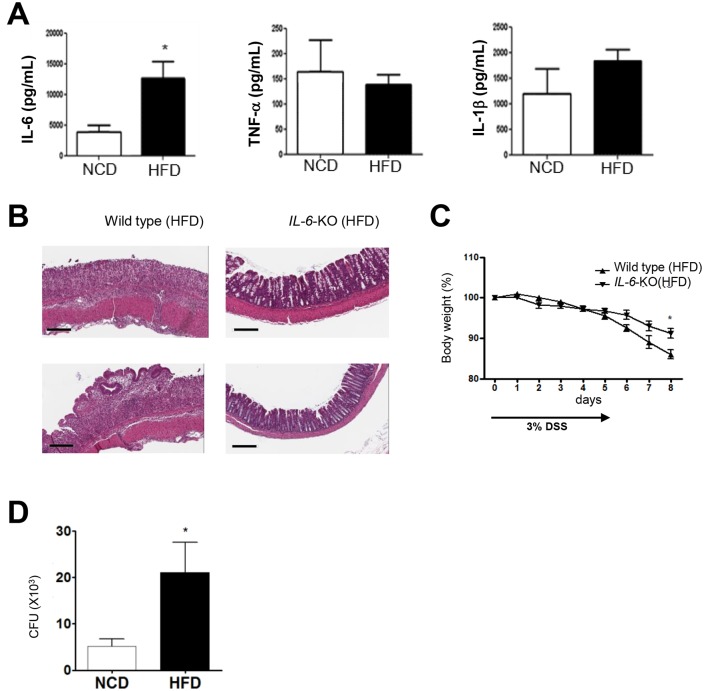
Cytokines in experimental colitis of high-fat diet (HFD)-fed mice.(A) Cytokine content in culture supernatant following overnight incubation of tissue explants was determined by ELISA on day 7 of dextran sodium sulfate (DSS) treatment. (B and C) Role of IL-6 in DSS-colitis of HFD-fed mice. DSS (3%) was administered to HFD-fed IL-6-knockout or wild-type mice for 5 days. Representative H&E sections of the colons on day 7 of DSS administration (B). Body weight is presented as a percentage of the initial body weight (C). (D) Bacterial translocation to the liver on day 7 of DSS treatment was quantified by colony-forming unit (CFU) counts (×1,000). All values are expressed as the means ± SEM. A student’s t-test was used to compare values between two groups. *P < 0.05 (n = 5 each). Original magnification, ×200. Scale bar, 100 μm.